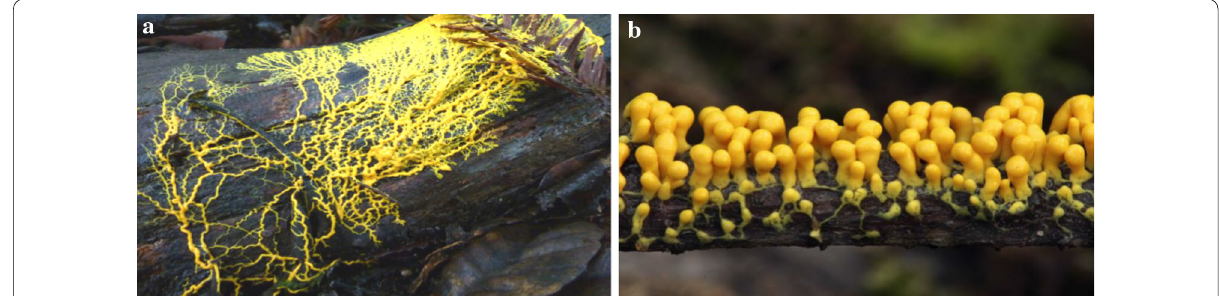
Fig. 2 a Plasmodium of the slime mold Physarum sp. b Sporangia of Physarum polycephalum (https:// calph otos. berke ley. edu)